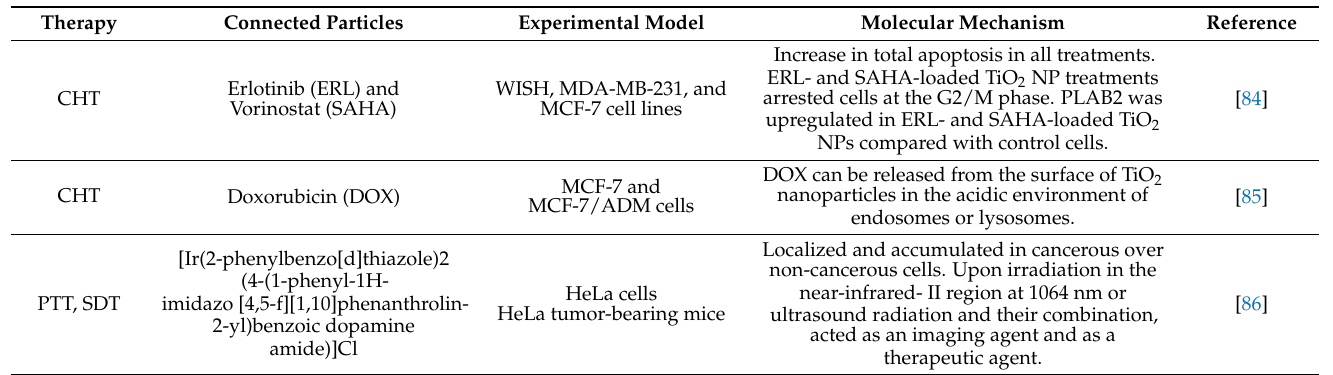
Table 8. Selected connections of biologically active molecules with titanium